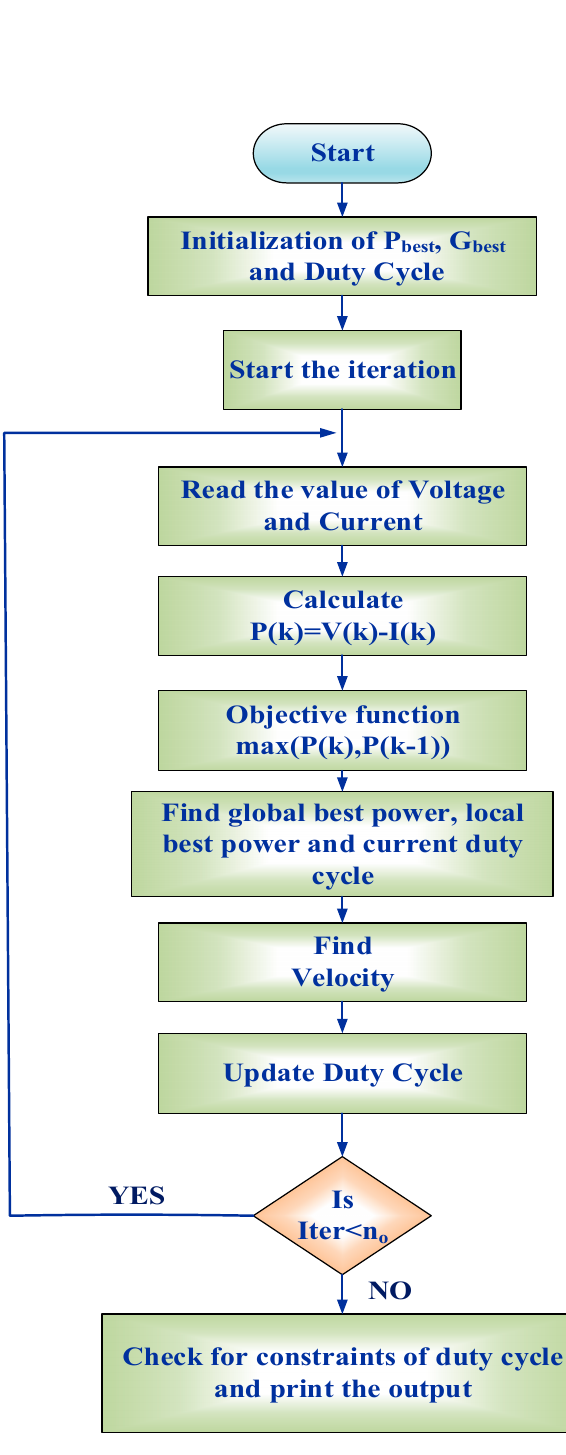
Figure 10. Flowchart of PSO algorithm.